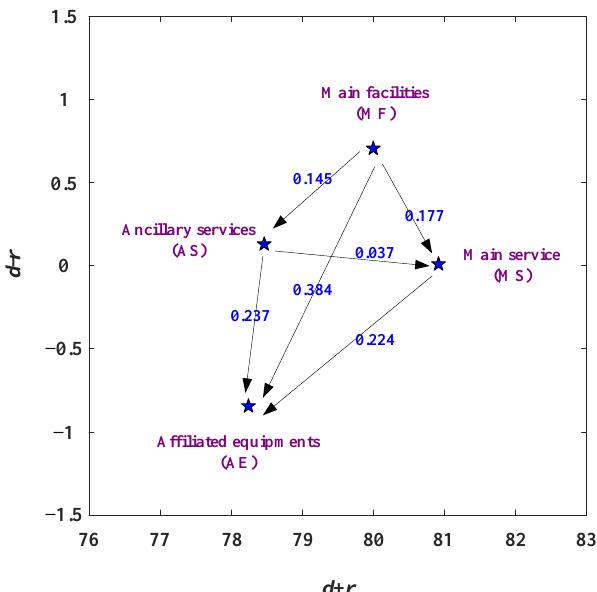
Figure 1. The development strategy map for public bike-sharing service systems.